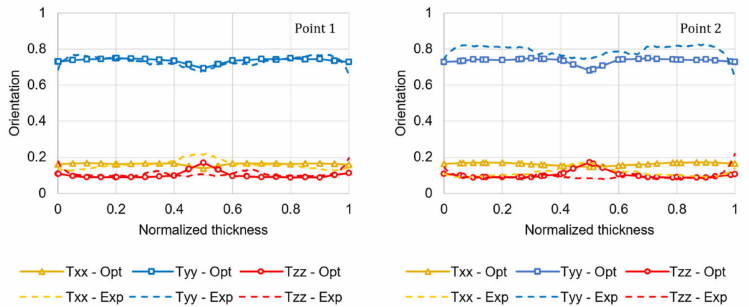
Figure 11. Comparison between the µ CT experimental results (Exp) of the fiber orientation tensor principal components and the numerical results (Opt) predicted using the optimized coefficients of the RSC model for the two ROIs in the tensile